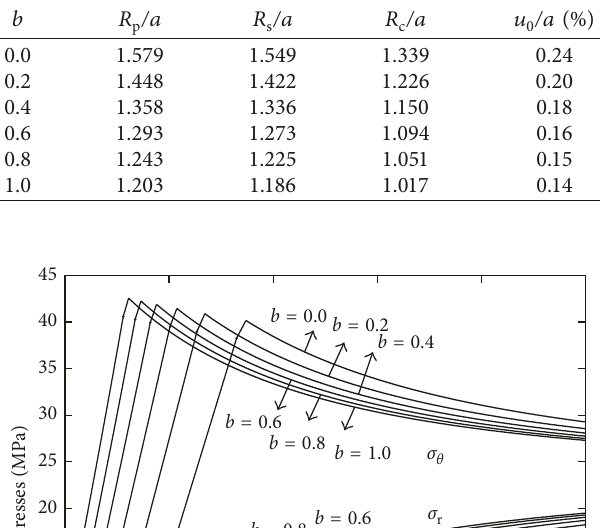
Table 5: The influence of the parameter b on the post-peak failure radii and surface